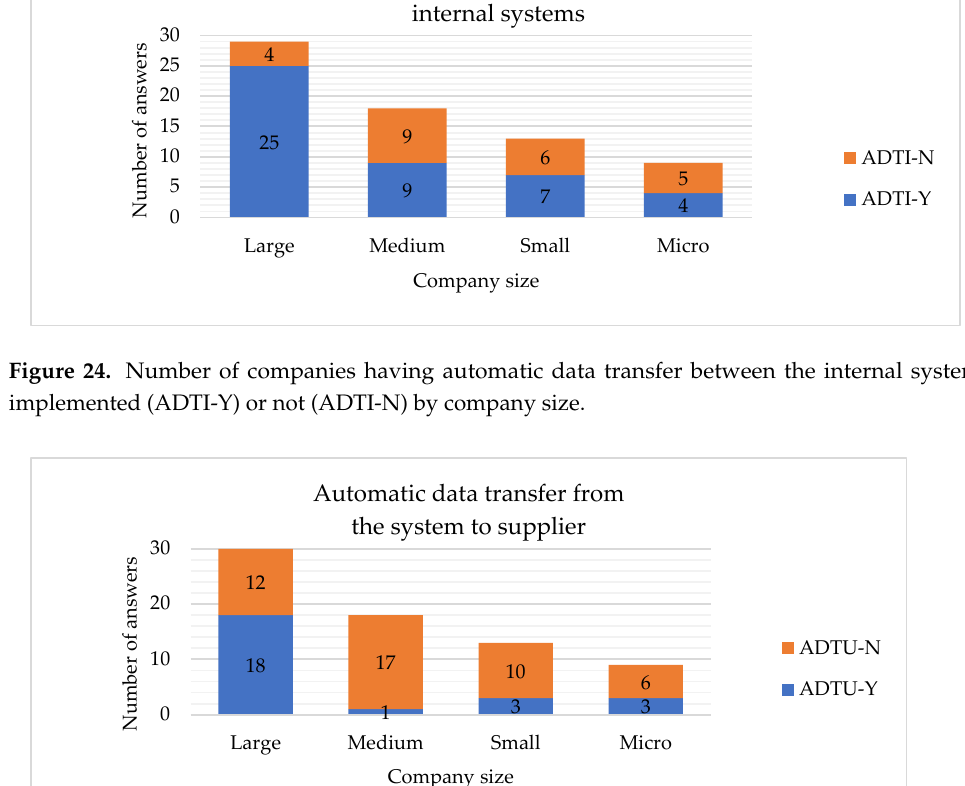
Figure 25. Number of companies having automatic data transfer from the system to supplier imple- mented (ADTU-Y) or not (ADTU-N) by company size.